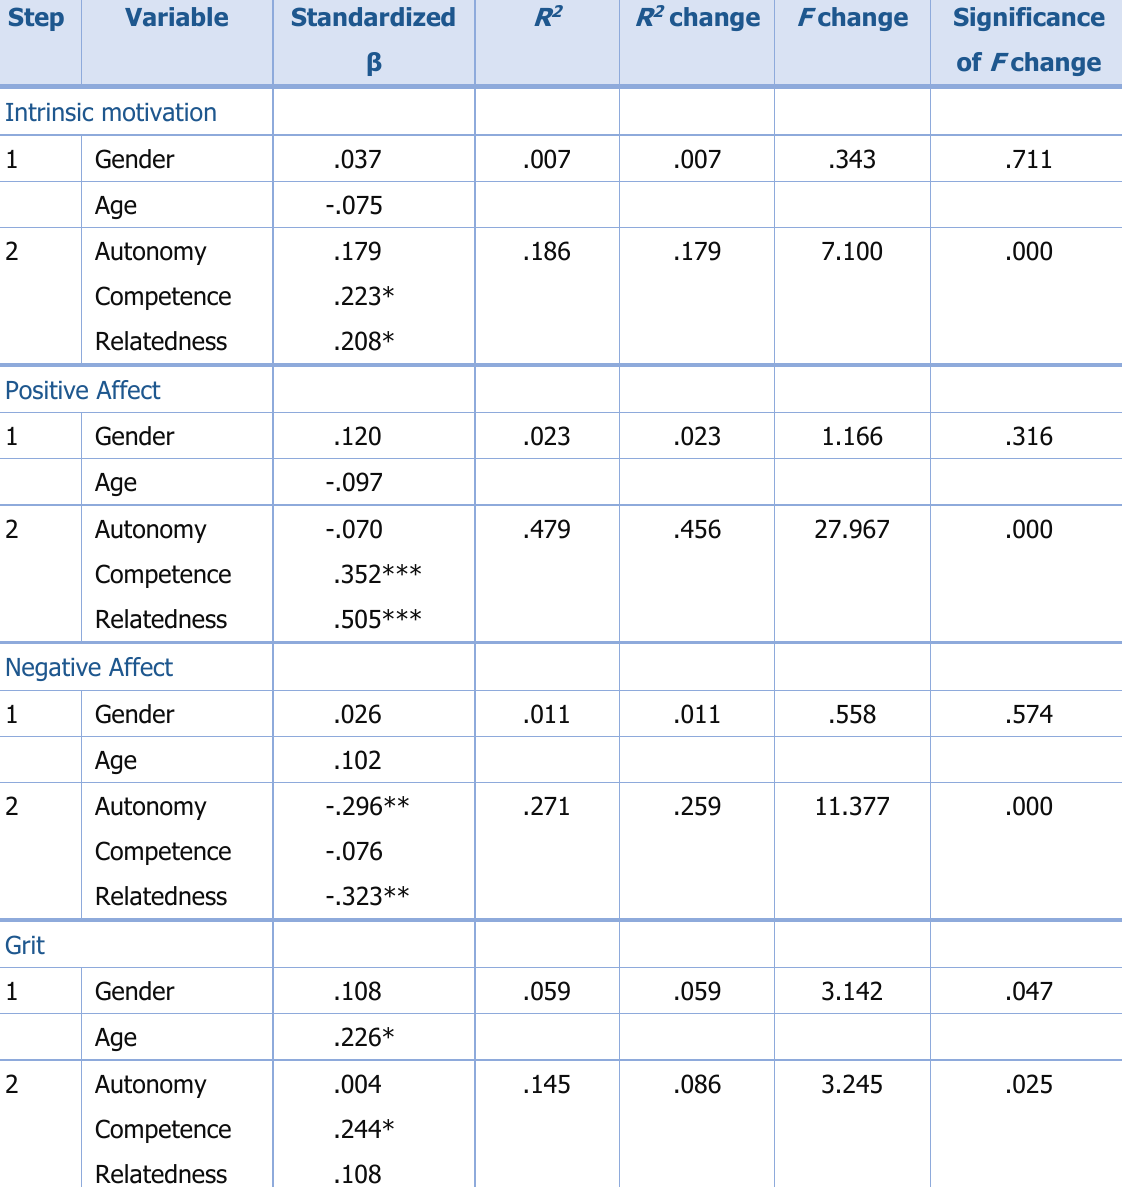
Table 3. Hierarchical Regression Analysis Predicting Intrinsic Motivation, Positive Affect, and Negative Affect From the Three Psychological